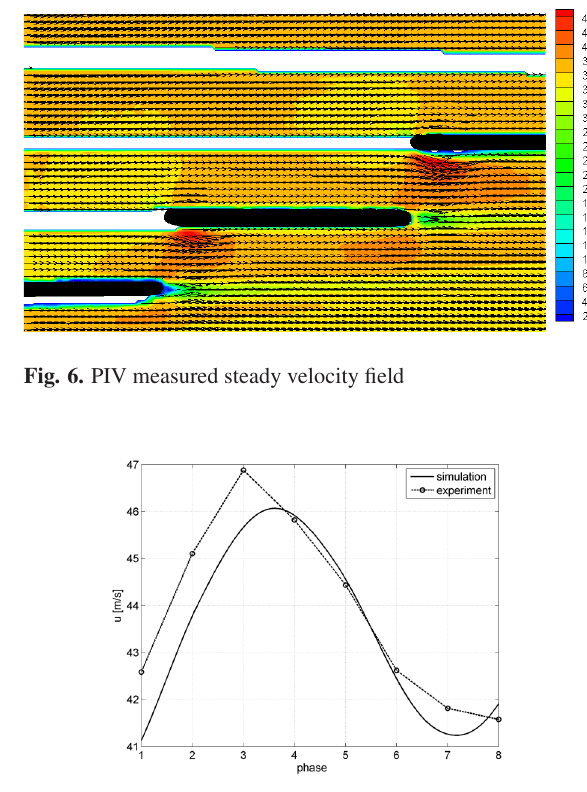
Fig. 7. Comparison of x component of velocity at point 1